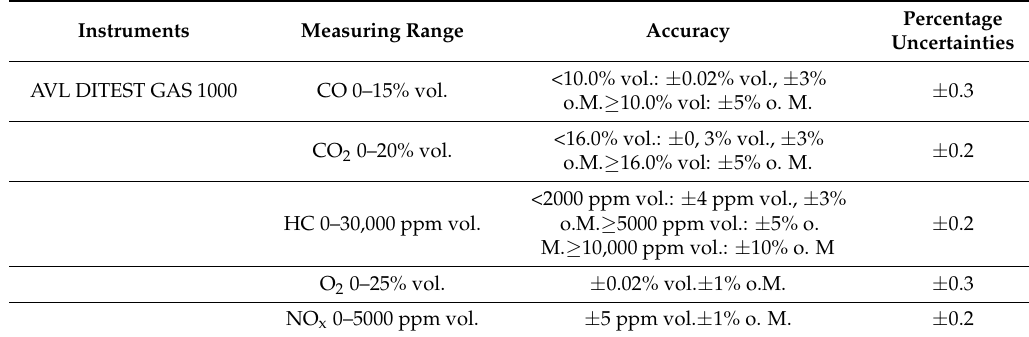
Table 4. Percentage uncertainties of various instruments.